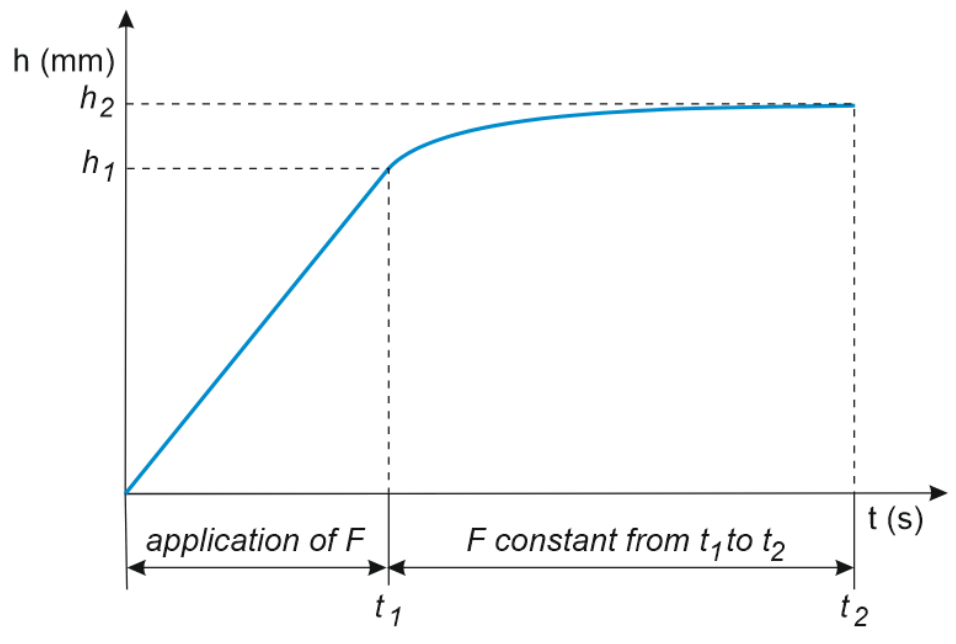
Figure 3. C IT creep parameter determination method.